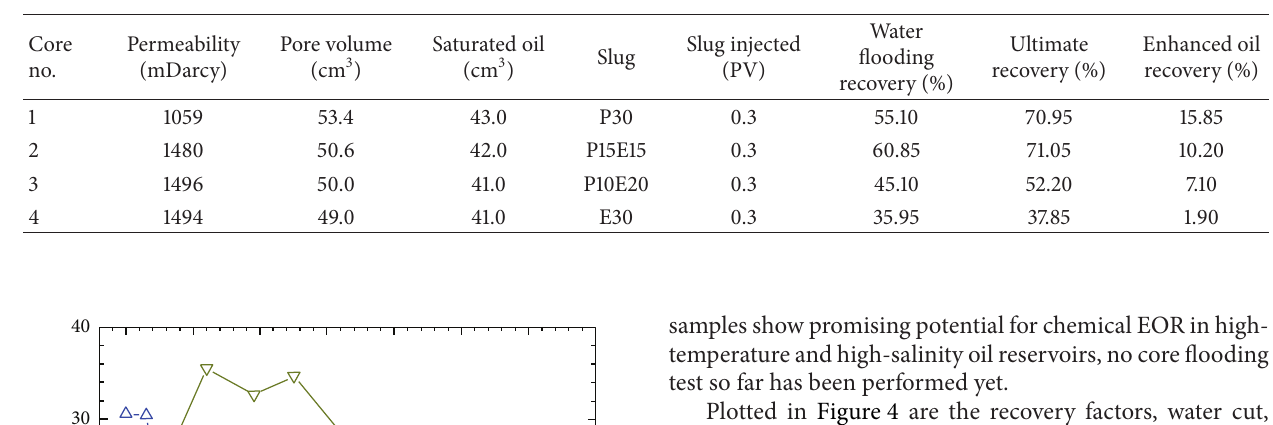
Table 3: Core parameters, displacement process, and recovery factors.